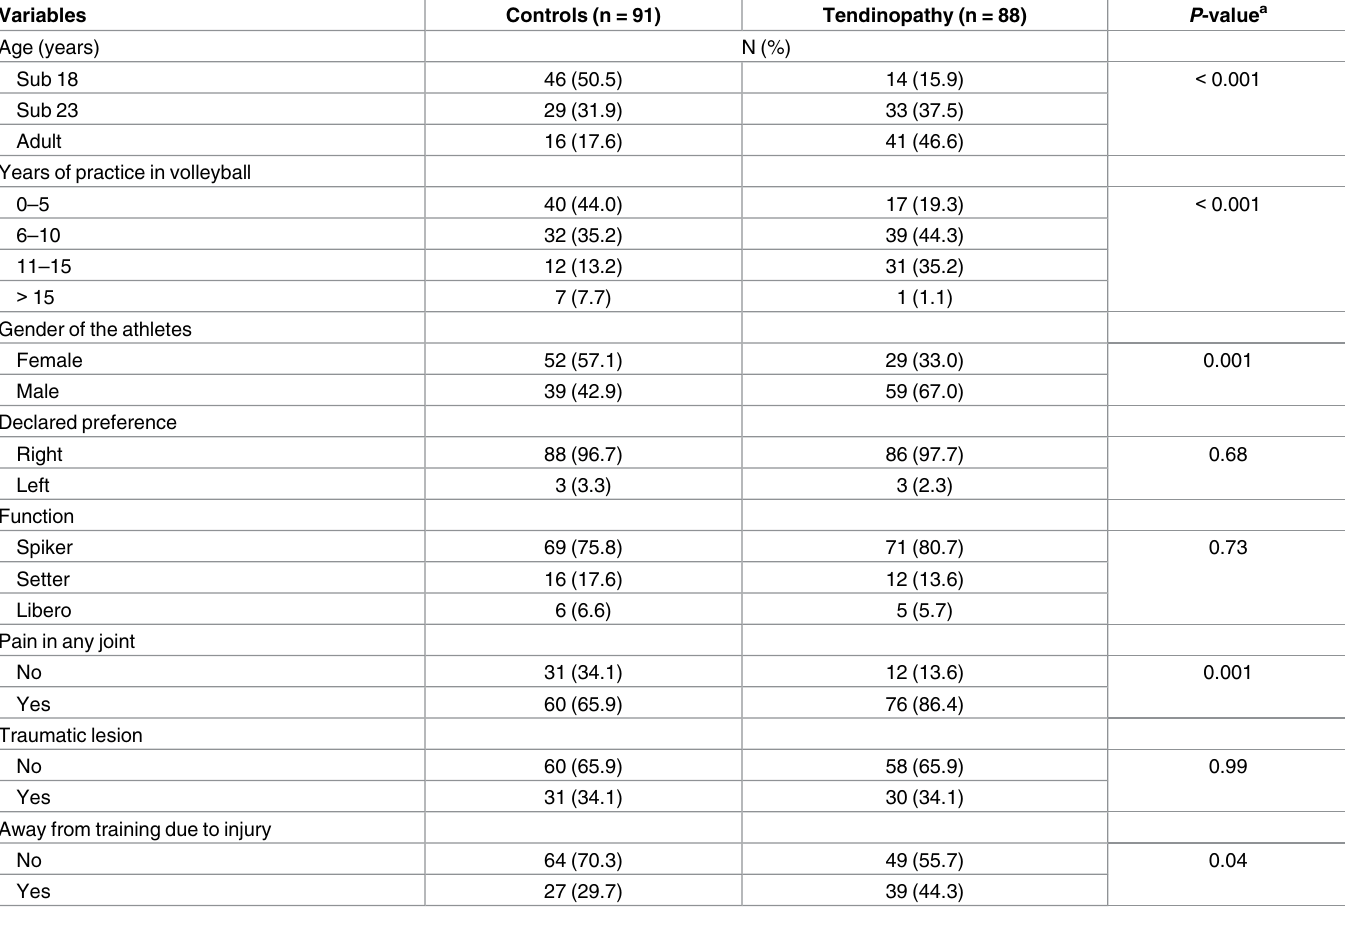
Table 2. Demographic and clinical characteristics of the volleyball